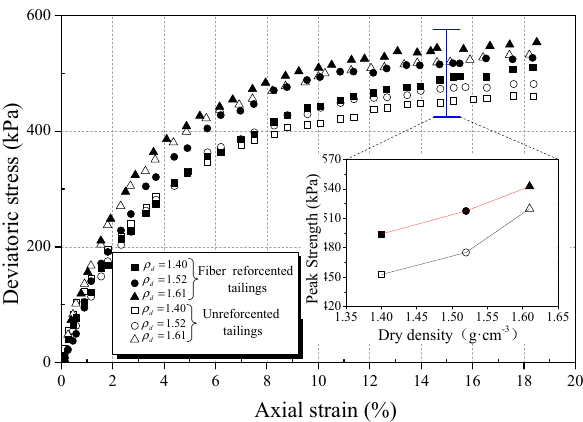
Figure 10. Effect of dry density on mechanical behavior of reinforced tailings clay (0.4 wt% fiber content).